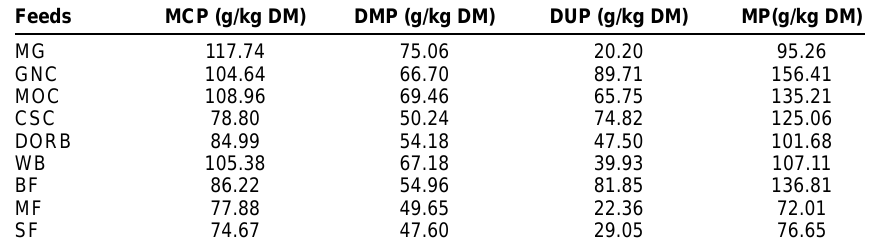
Table-6: Metabolizable protein content of